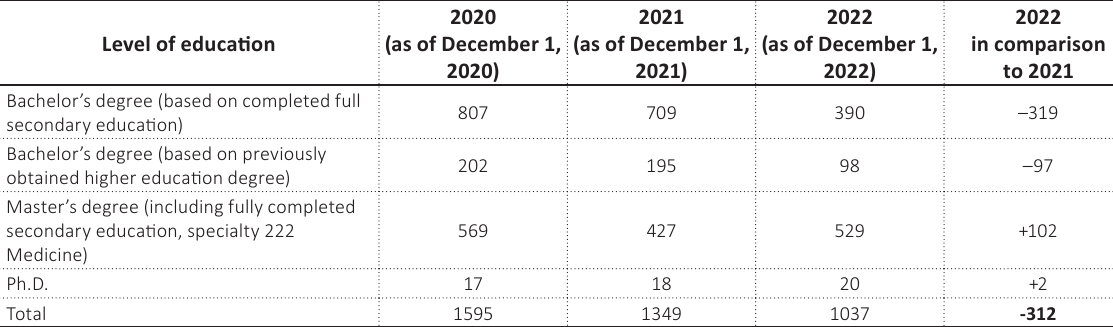
Table 1. Comparative analysis of the enrolment at Kherson State University,